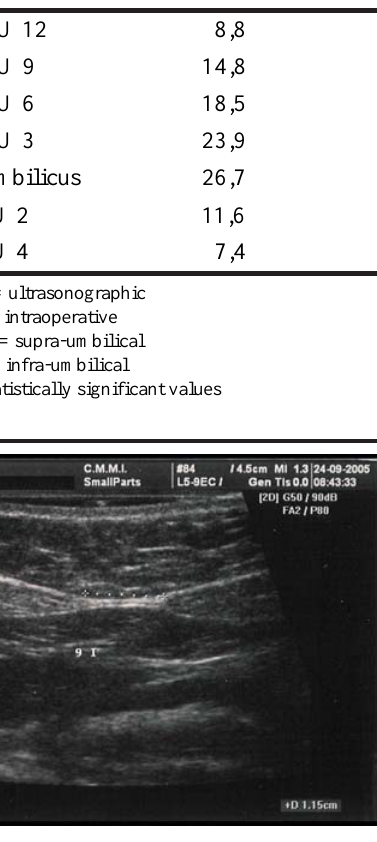
FIGURE 3 - Ultrasonographic image at infra-umbilical level, showing the loss of definition of the posterior layer of recti muscles. Therefore, it is difficult to measure